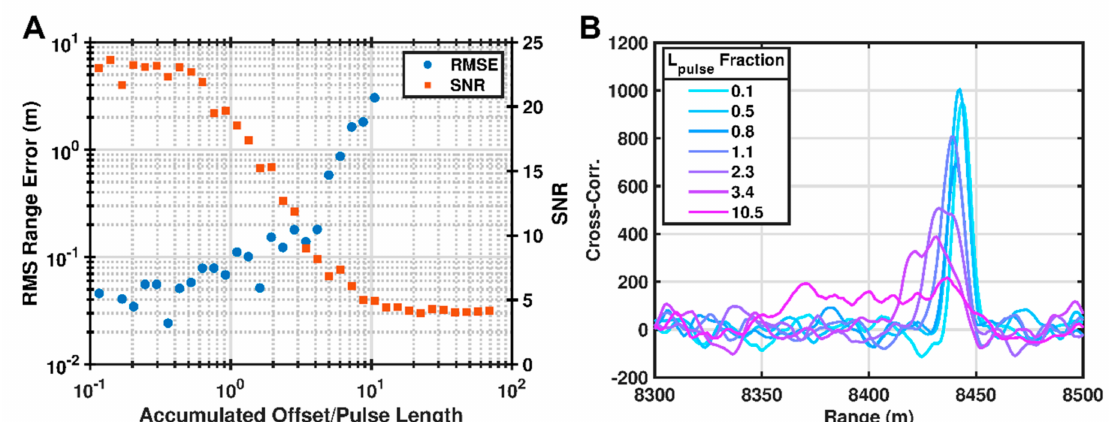
Figure 13. PN ranging performance under varying levels of accumulated Doppler shift. The accumulated Doppler shift is normalized here as the ratio of the accumulated shift to the pulse length. ( A ) RMS ranging error and average SNR of five independent measurements at each accumulated Doppler shift following the conventions of Figures 10 and 12. ( B ) Plots of a subset of cross-correlation peaks from the simulation in ( A ) showing the peak-spreading due to the Doppler the